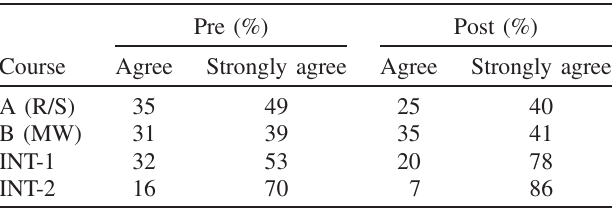
TABLE III. Percentage of matched students from each course who at pre- and (or) postinstruction either agreed or strongly agreed with the statement: I think quantum mechanics is